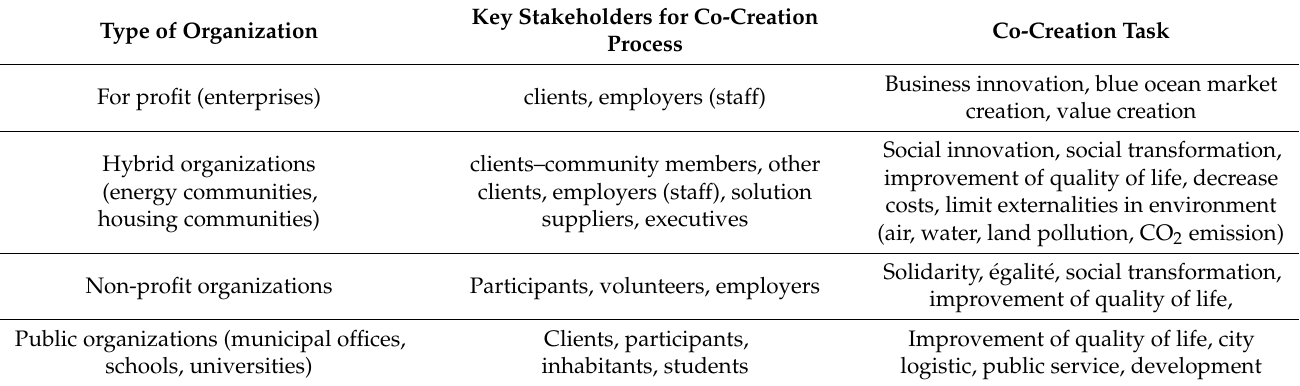
Table 2. Co-creation in different